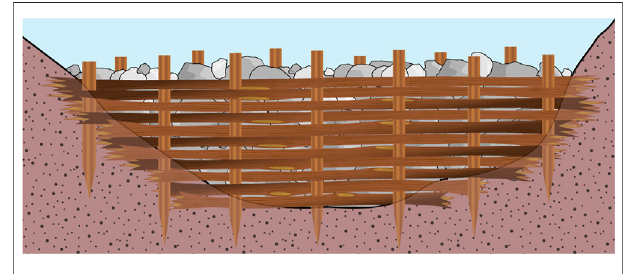
FIGURE 11 | Sketch of a gully